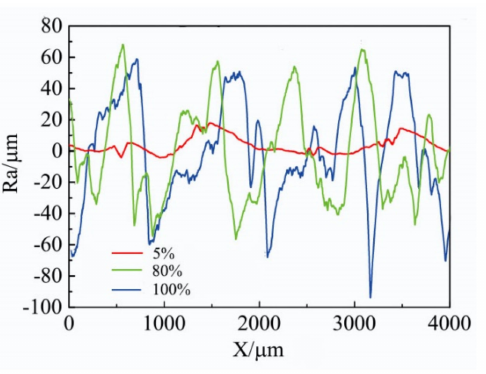
Figure 3. Roughness curves of the nitrided layers obtained in pure nitrogen (100%) (blue line), 80% nitrogen, and 20% argon (green line), and 5% nitrogen and 95% argon (red line) gas